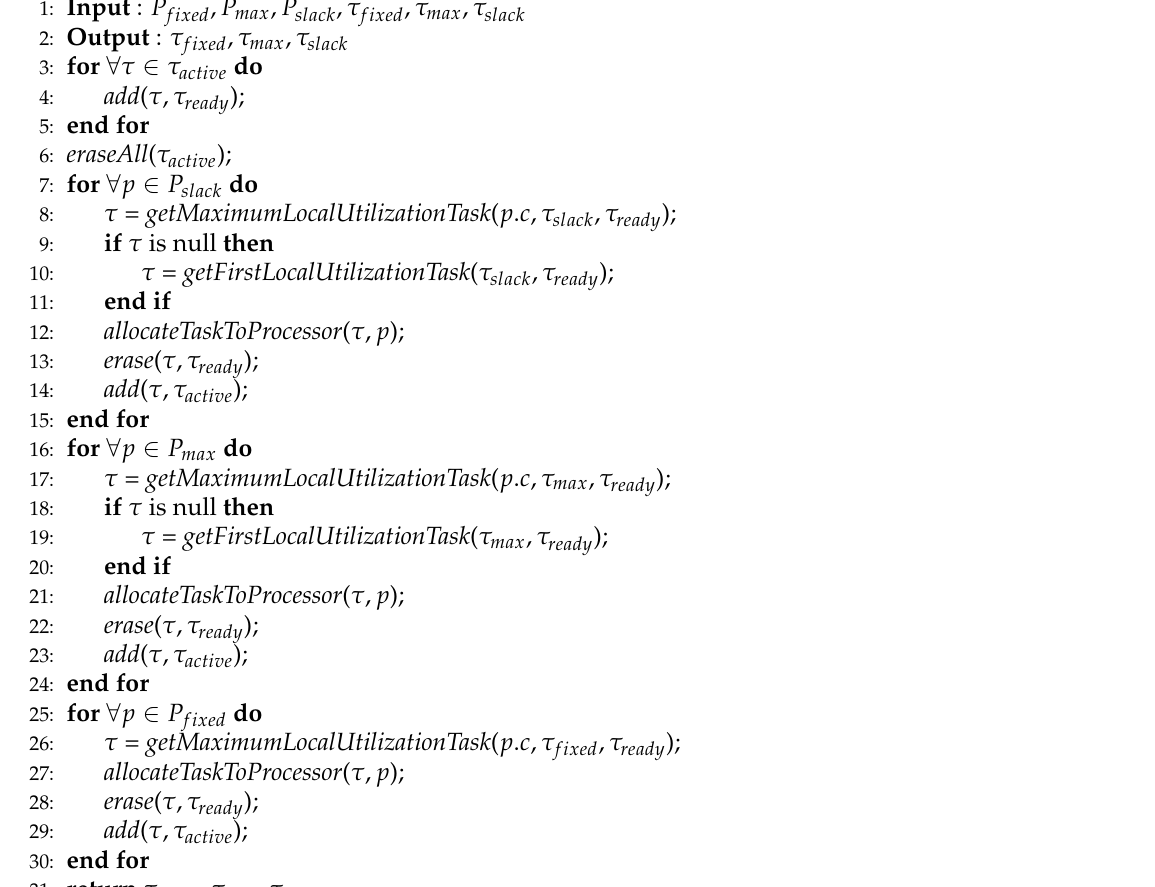
Algorithm 3 Assignment of tasks to processors at